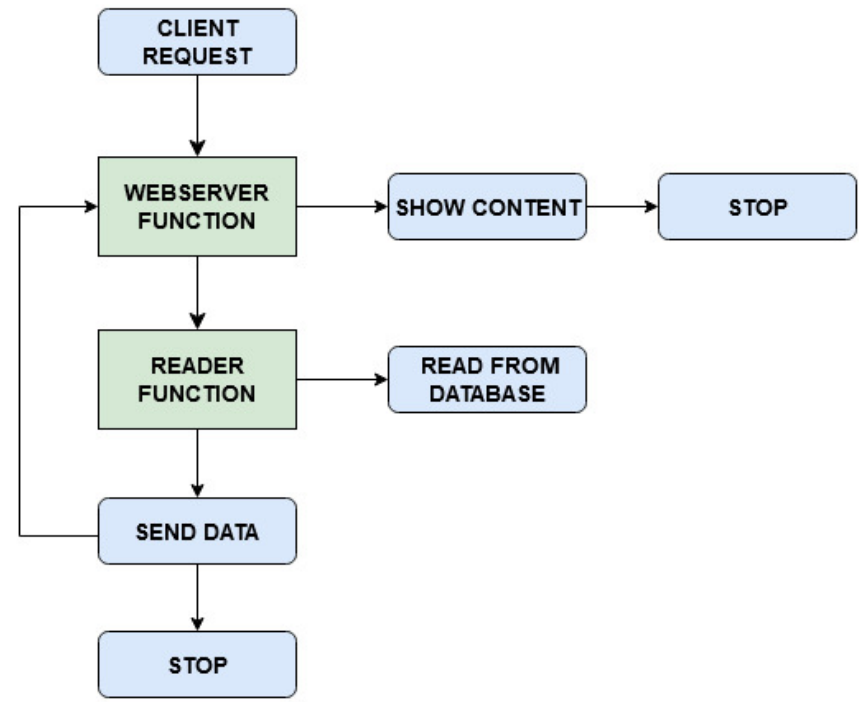
Figure 3. Flowchart for client request serving